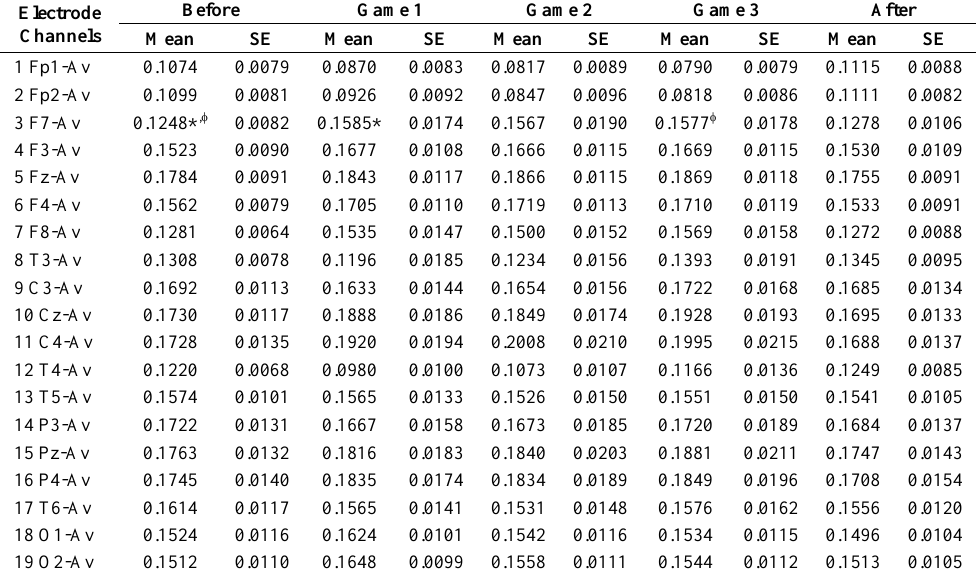
Table 5 Alpha relative band powers between non-gameplays and during gameplays (*: before-game1,  : before-game3, p-value < 0.001) Before Game 1 Electrode Channels